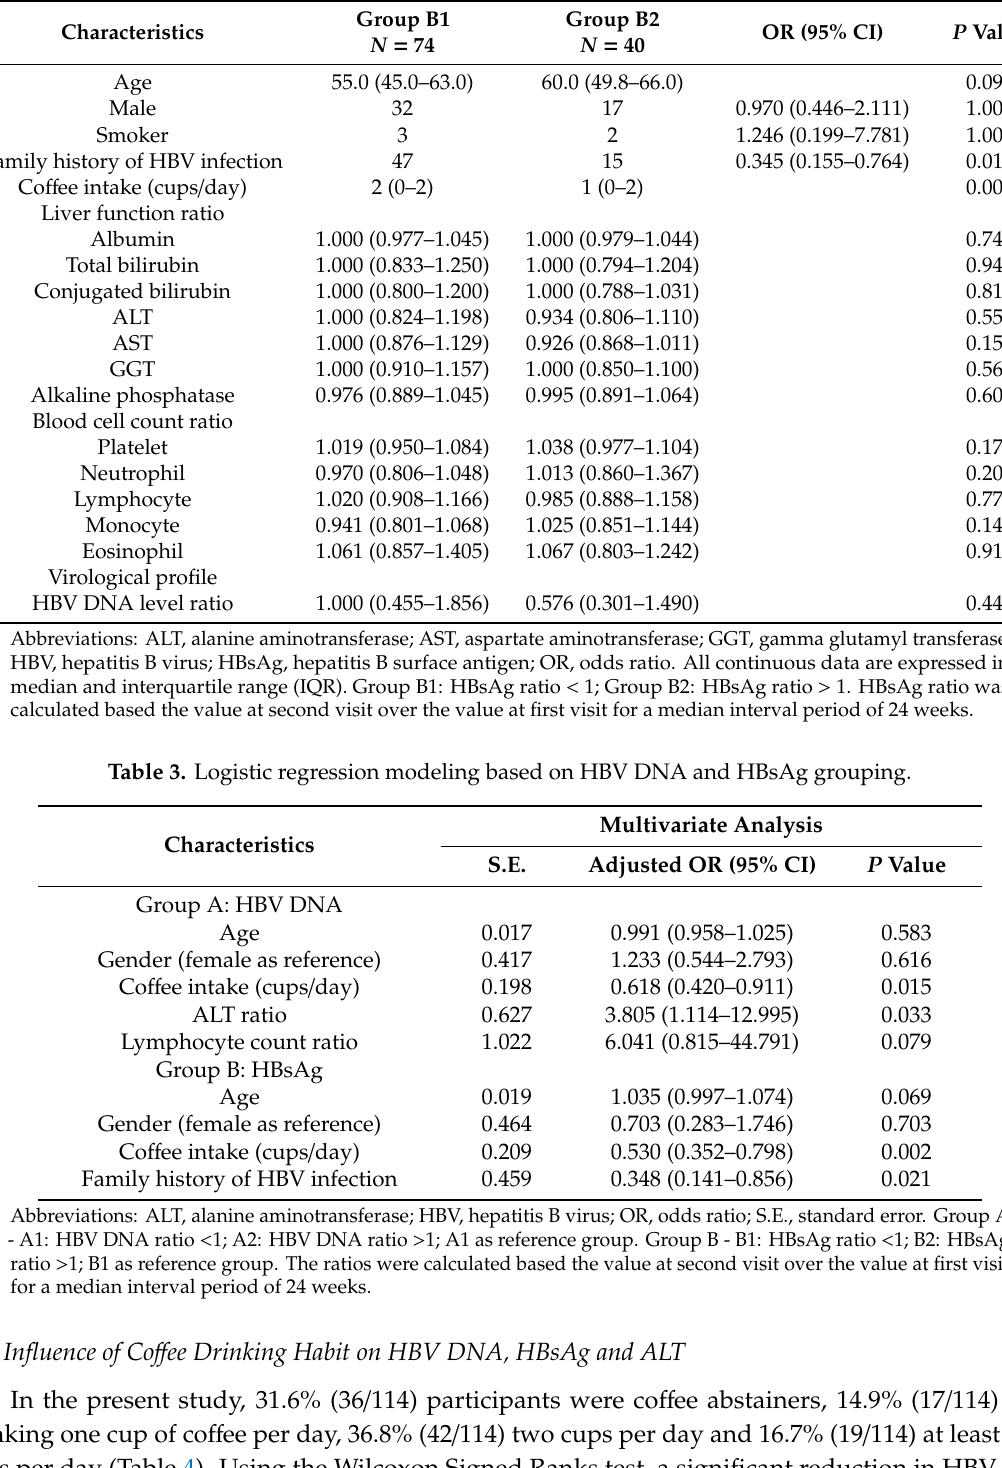
Table 2. E ff ects of demography, liver function, blood cell and virological profiles on HBsAg level by univariate analysis.